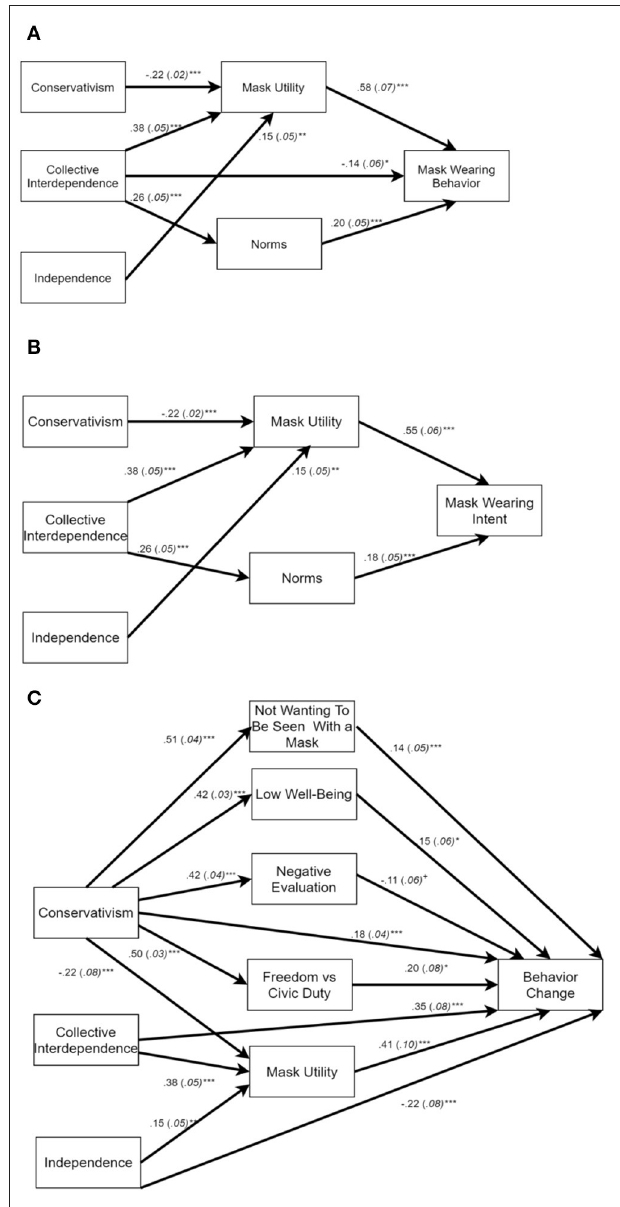
FIGURE 1 | Mediation models pertaining to mask-wearing behaviors. The figures depict only paths involved in a reliable indirect (mediation) effect; and significant direct effects of the cultural predictors onto the behavior variables and onto the mediators. (A) refers to past mask wearing behavior; (B) to future mask wearing intent; and (C) to willingness to change one’s behavior. * p < 0.05; ** p < 0.01; *** p <